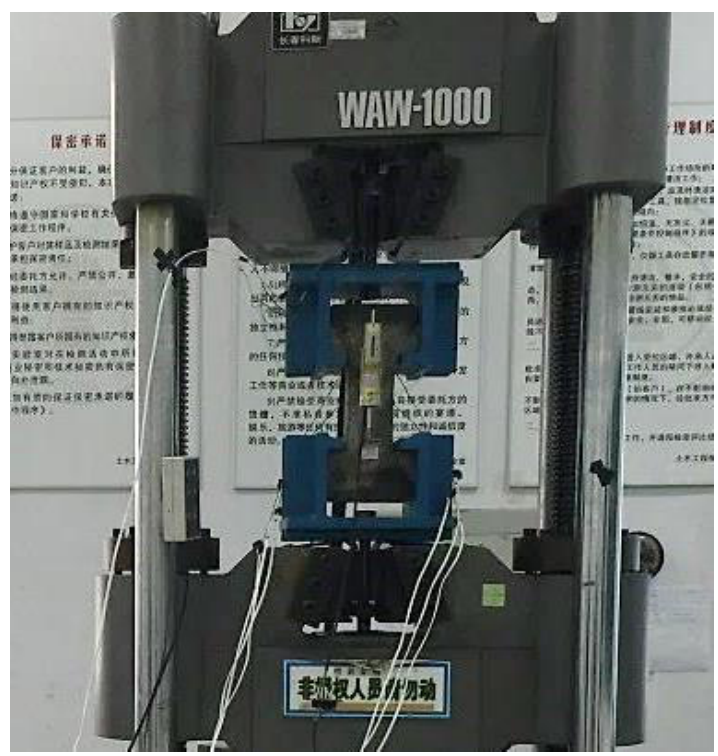
Figure 4. Diagram of loading device for the RPC axial tensile test.